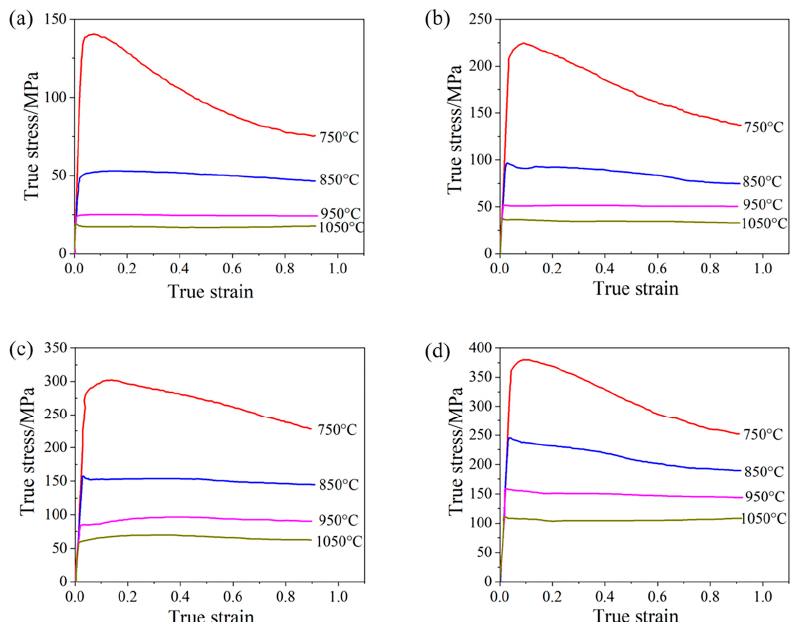
Figure 1. True stress–strain curves of Ti555211 sample on various deformation conditions: ( a ) . . . . ε = 0.005 s − 1 ; ( b ) ε = 0.05 s − 1 ; ( c ) ε = 0.5 s − 1 ; ( d ) ε = 5 s − 1 .